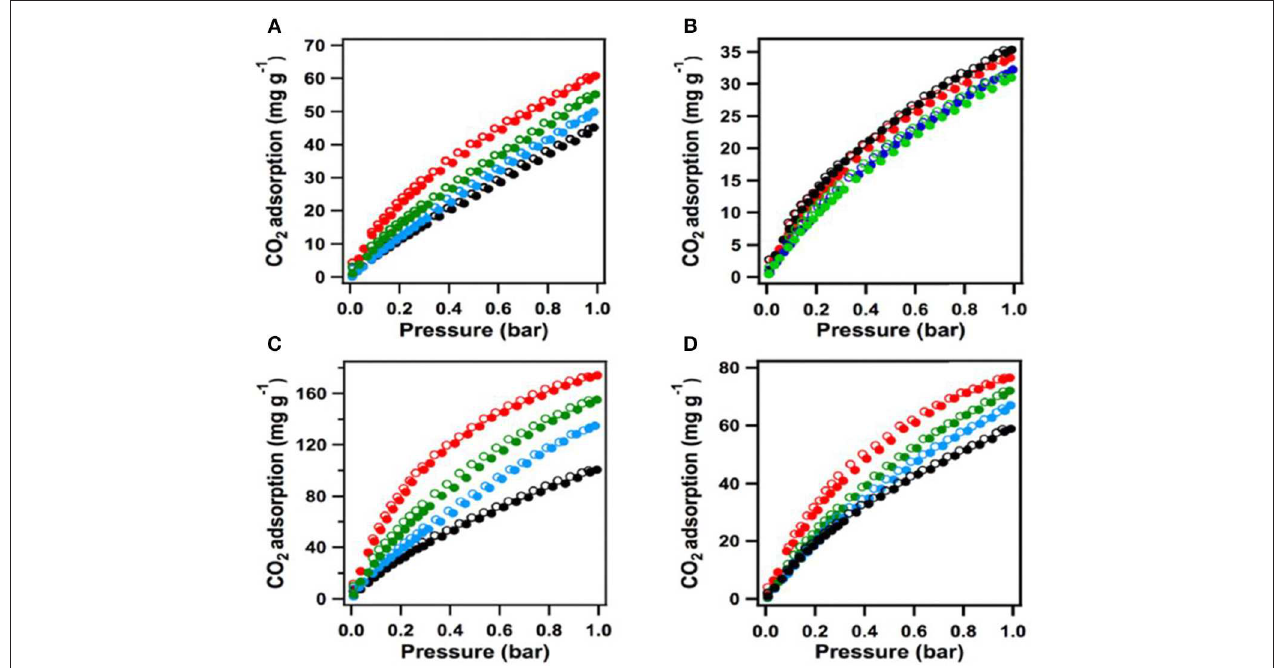
FIGURE 8 | The [HO] x % -H 2 P-COF CO 2 sorption curves measured at (A) 273K and (B) 298K (black [HO] 25 % -H 2 P-COF CO 2, blue: [HO] 50 % -H 2 P-COF CO 2, green: [HO] 75 % -H 2 P-COF CO 2 , red: [HO] 100 % -H 2 P-COF CO 2 . The CO 2 sorption curves of [HO 2 C] x % -H 2 P-COFs measured at (C) 273K and (D) 298K (black: [HO 2 C]25%-H 2 P-COF, blue: [HO 2 C]50%-H 2 P-COF, green: [HO 2 C]75%-H 2 P-COF, red: [HO 2 C]100%-H 2 P-COF). Filled circles represent adsorption and open circles represent desorption. Reprinted with Permission © 2015 Wiley